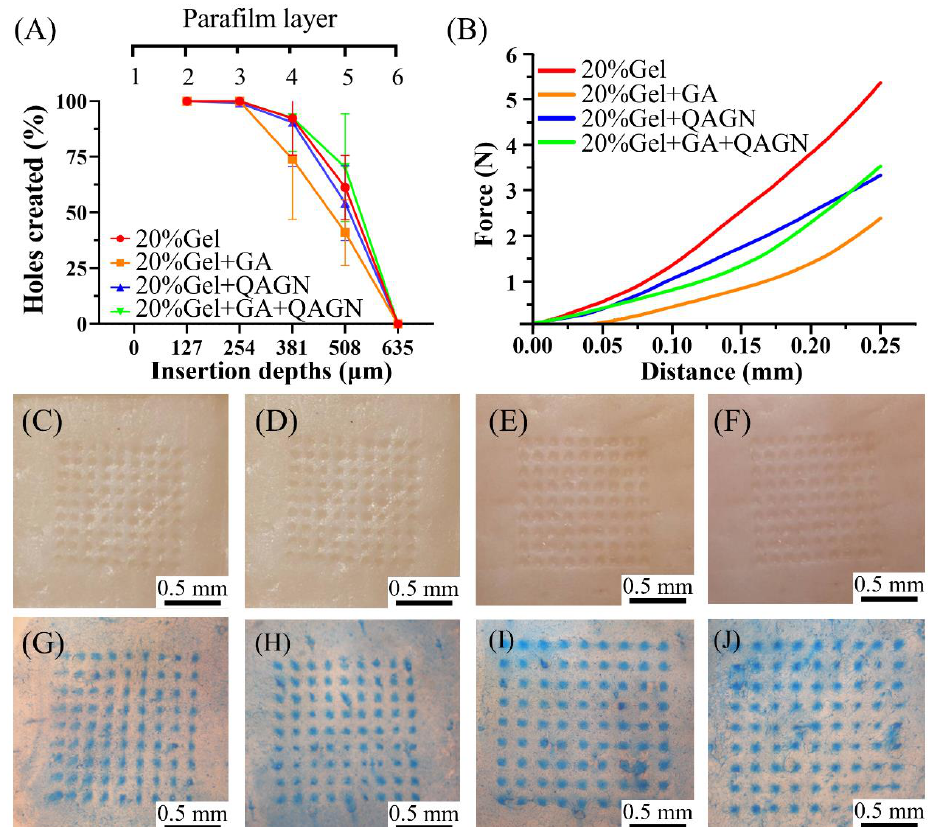
Figure 4. Evolution of MN patches’ insertion ability. ( A ) Mechanical properties analysis; ( B ) Parafilm insertion simulations. The porcine skin insertion photographs represent ( C ) pure Gel, ( D ) GA-loaded, ( E ) QAGN-loaded, and ( F ) GA + QAGN-loaded MN patches. The trypan blue staining for labelling the porcine skin insertion locations represents ( G ) pure Gel, ( H ) GA-loaded, ( I ) QAGN-loaded, and ( J ) GA + QAGN-loaded MN patches.